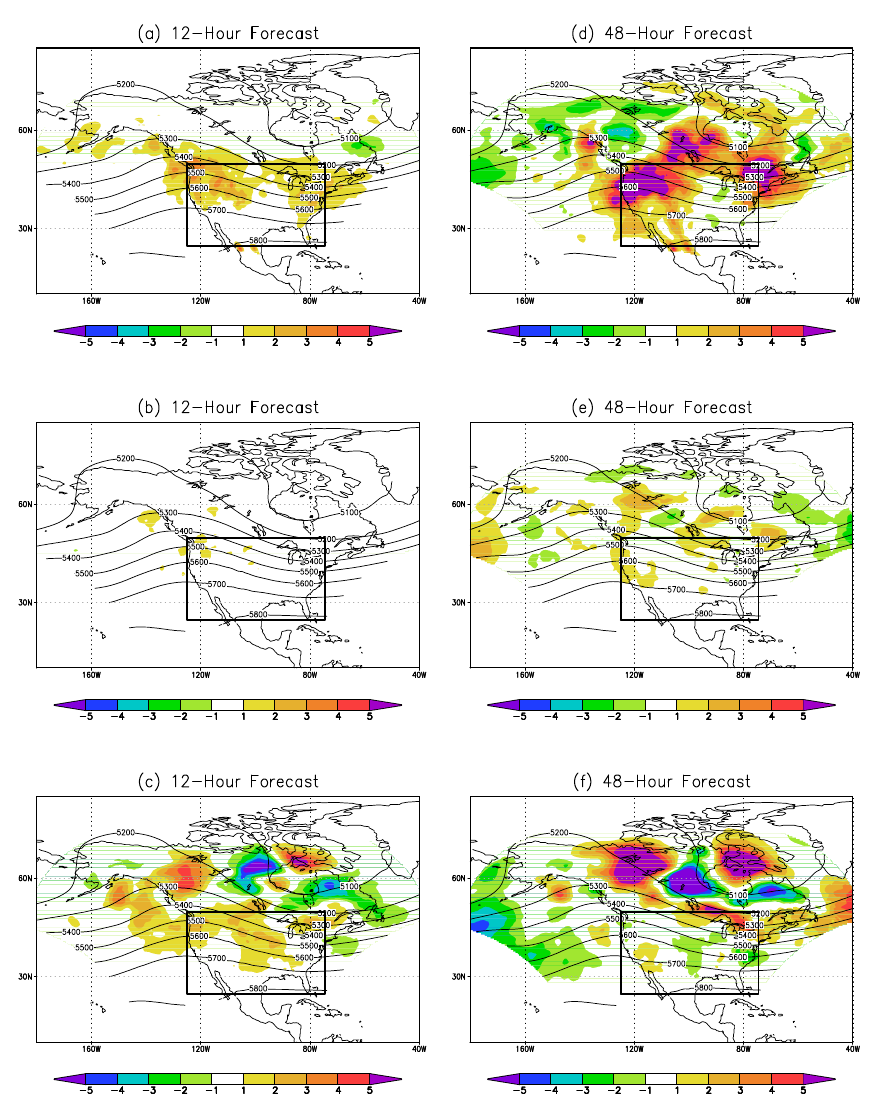
Fig. 7. Same as Fig. 6, except for the geopotential height forecast at the 500hPa